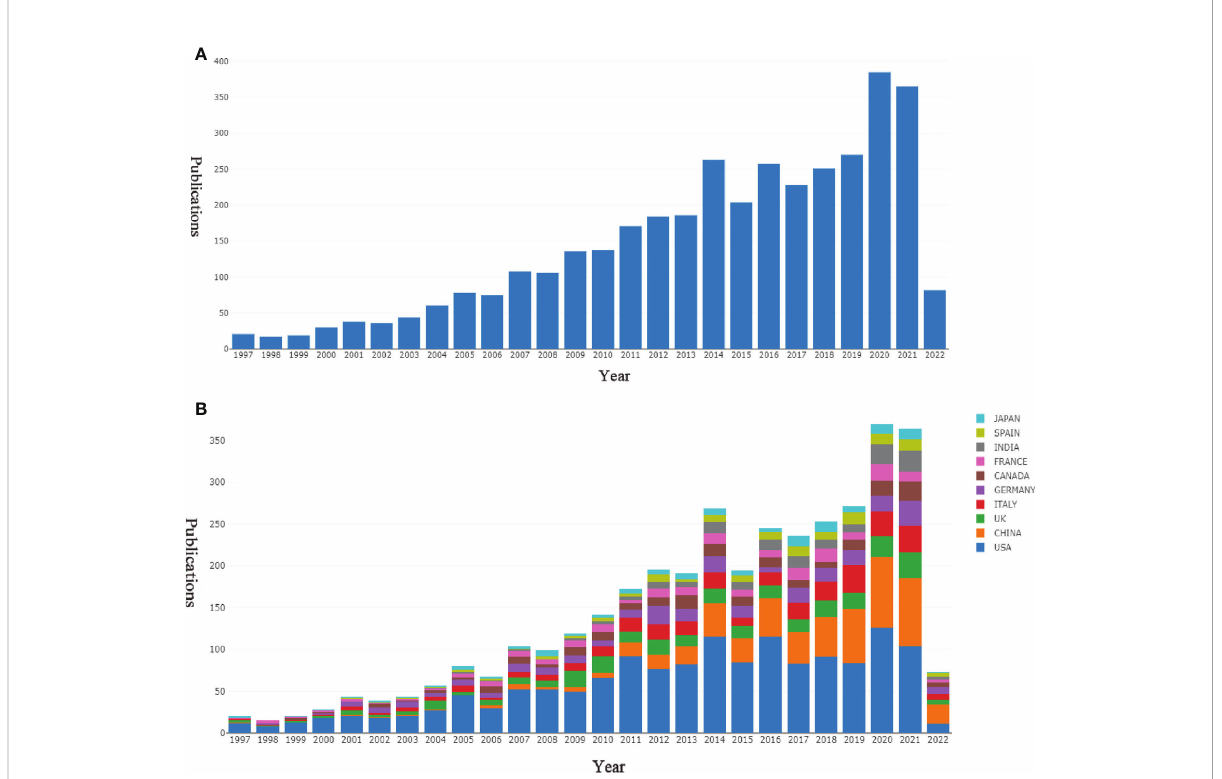
FIGURE 2 Output of related literature. Source: authors with Online Analysis Platform of Bibliometrics (http://bibliometric.com/). Bar chart re fl ects number of online articles per year. (A) The number of annual publications. (B) Growth trends of the top 10 countries/regions in PTMs and cancer fi eld from 1997 to